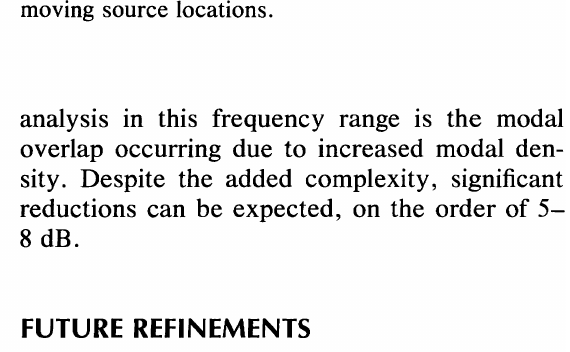
FIGURE 5 Calculated pressure levels for the Space Station at selected frequencies, showing the benefit of moving source